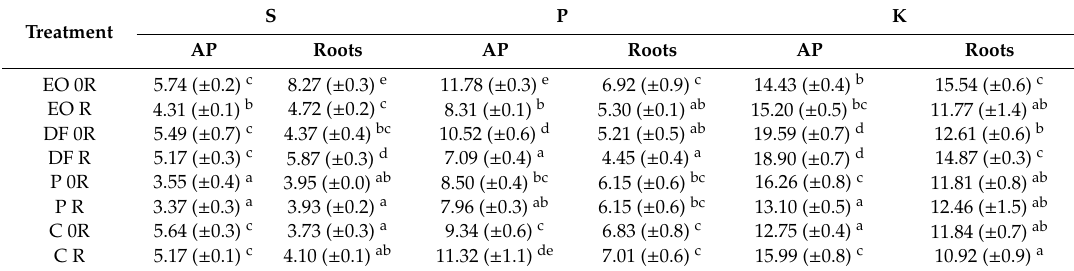
Table 3. The e ff ect of petroleum-derived substances and bioremediation on the content of selected nutrients in the aboveground parts (AP) and roots of Vicia faba L. (g kg − 1 ).